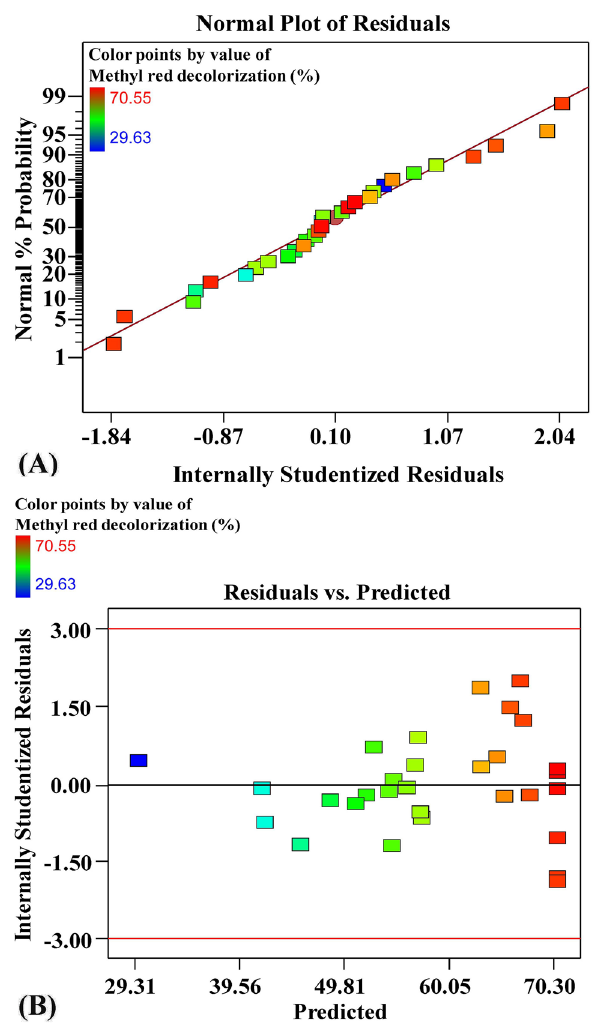
Figure 2. ( A ) Normal probability plot of internally studentized residuals, ( B ) plot of internally studentized residuals versus predicted values of methyl red decolorization (%) by using Scenedesmus obliquus as determined by a second-order polynomial